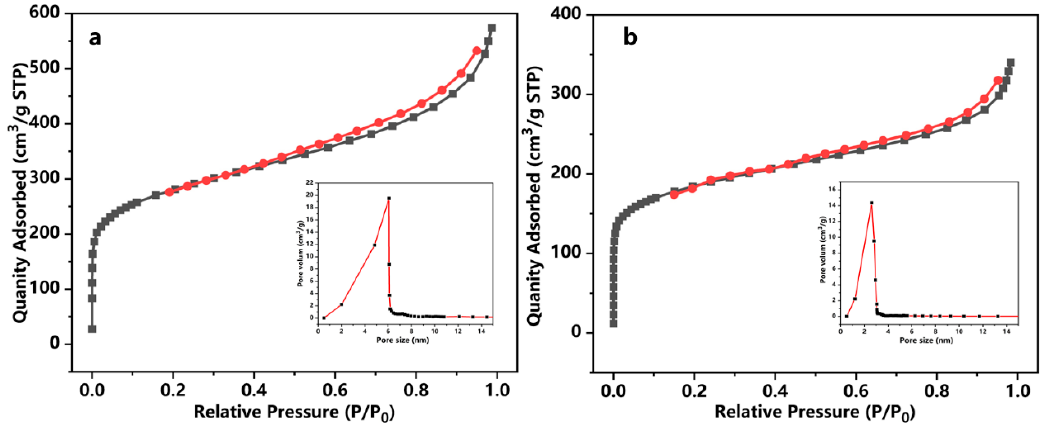
Figure 5. Nitrogen adsorption–desorption isotherms and pore size distributions (insert figures) for ( a ) HCP pitch –CH 2 –Cl and ( b ) [HCP pitch –Im–Pros][Tos]. Table 2. Surface area and porosity of HCP pitch , HCP pitch –CH 2 –Cl, and [HCP pitch –Im–Pros][Tos]. Sample